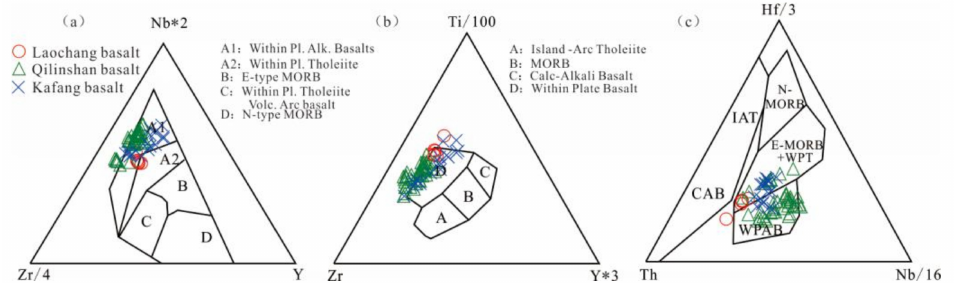
Figure 12. ( a ) Nb–Zr–Y diagram (modified from [74]); ( b ) Ti–Zr–Y diagram (modified from [75]); ( c ) Hf–Th–Nb diagram (modified from [77]), IAT: Island arc tholeiite, CAB: Calc-alkaline basalt, N-MORB: Normal mid ocean ridge basalt, E-MORB: Enriched mid ocean ridge basalt, WPT: Within plate tholeiite, WPAB: Within plate alkaline basalt. The data of Kafang from